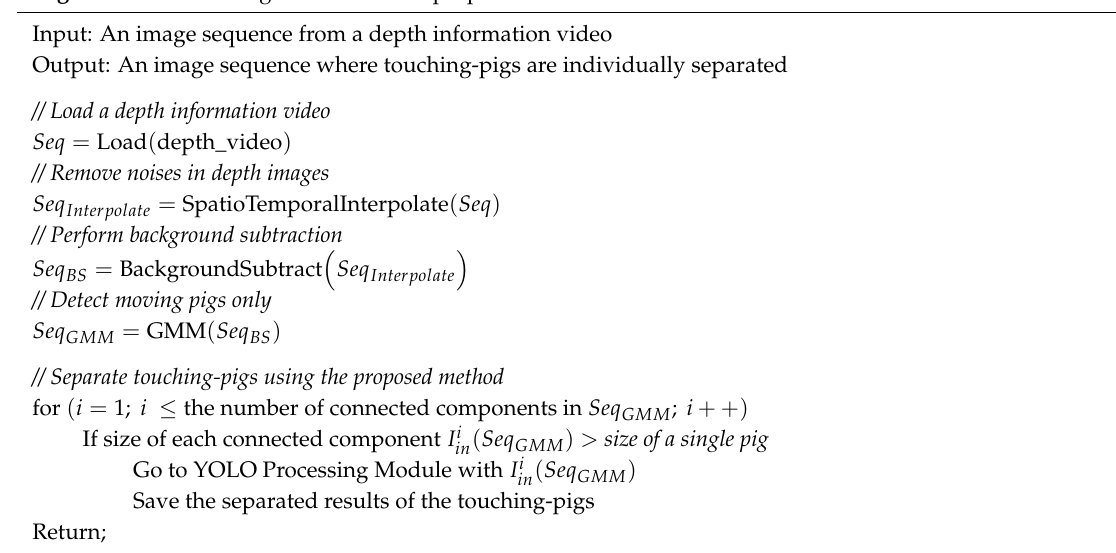
Algorithm 1 Overall algorithm with the proposed